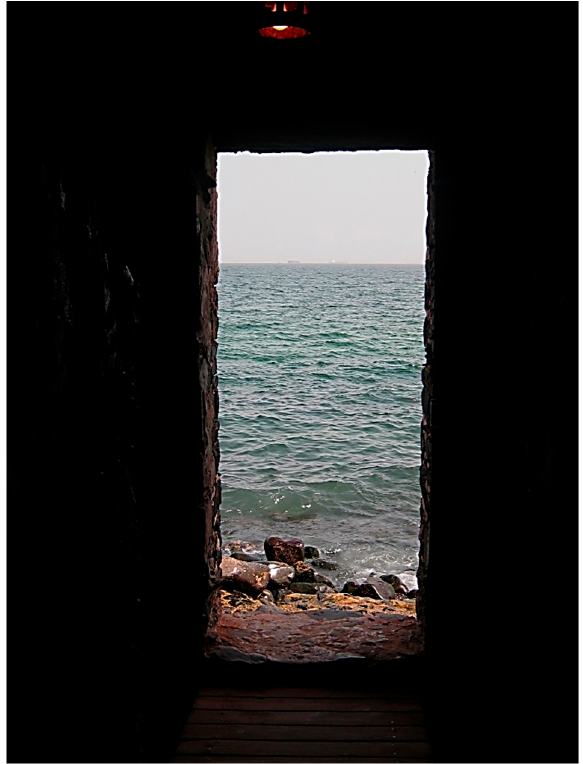
Figure 4. “The Door of No Return” (La Porte du Non Retour de la Maison des Esclaves). Wikimedia Commons (photo by Wandering Angel).